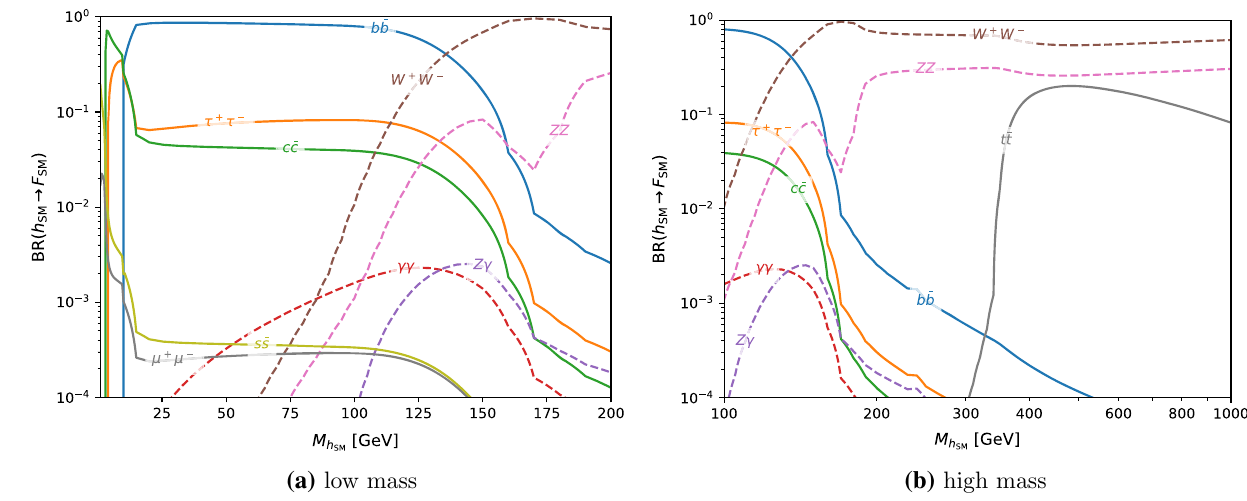
panel ) and the high mass region ( right panel ). The numerical values are , in taken from Ref. [77], see text for further SM